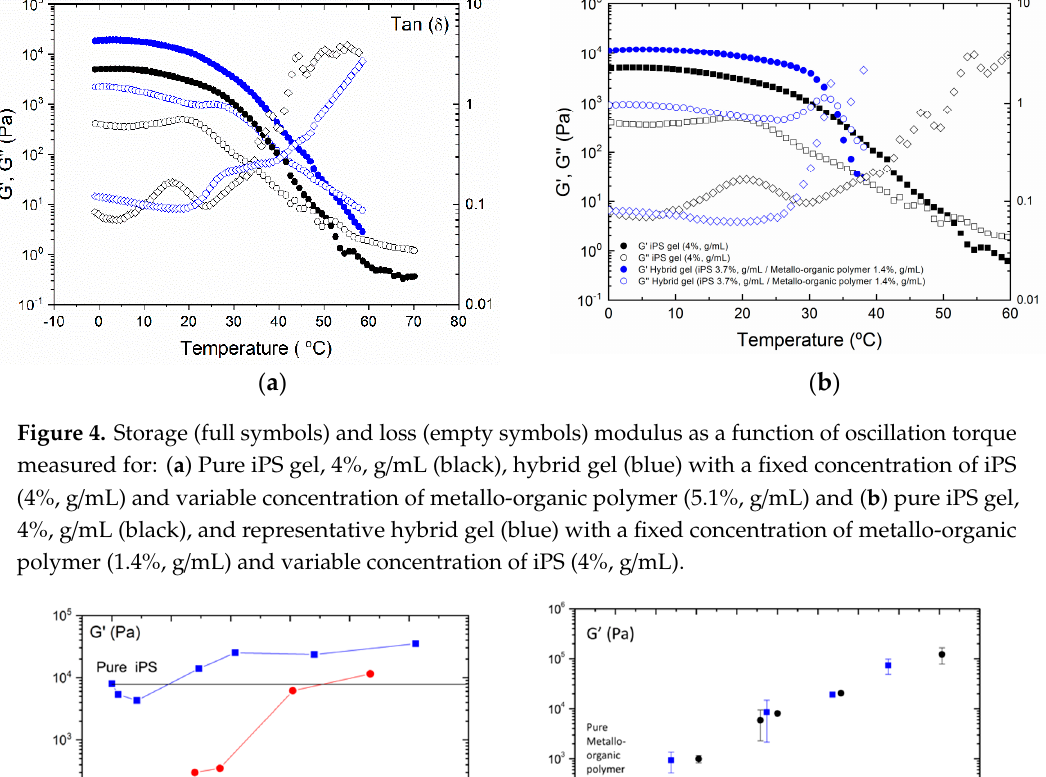
( b ) Figure 6. ( a ) Double logarithmic plot of the equilibrium storages modulus plateau as a function of metallo-organic polymer concentration for hybrid gels with a fixed iPS concentration of 4%, g/mL (blue square) and for pure metallo-organic polymer gels (red circle) and ( b ) as a function of iPS